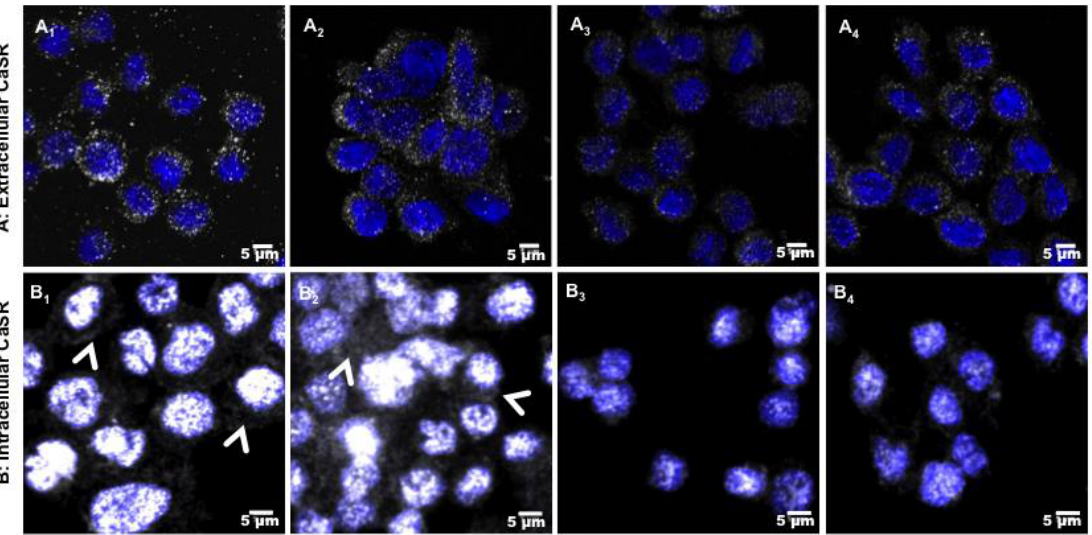
Figure 5. Calcium sensing receptor (CaSR). Fluorescent images of extracellular ( A ) and intracellular ( B ) CaSR by THP-1 in contact with CaP-CHI-HA ( A 1 , B 1 ), CaP ( A 2 , B 2 ), LPS ( A 3 , B 3 ) and glass ( A 4 , B 4 ), showing an increase of intracellular labelled CaSR (head arrows) on built-up substrates. Grey colors correspond to CaSR, blue to nuclei and purple for merged CaSR/nuclei (scale bars indicate 5 μm).